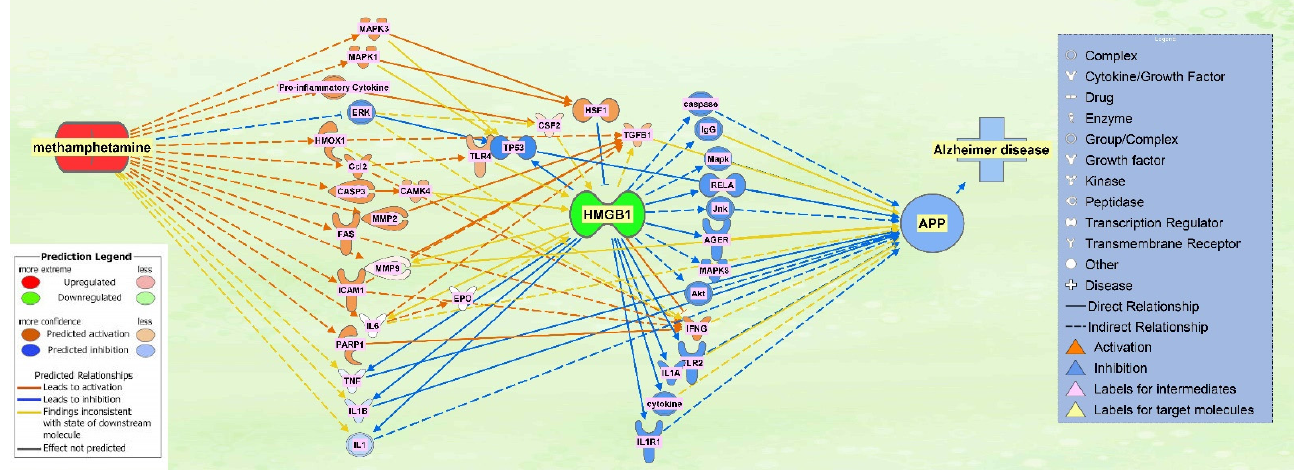
Figure 9. Activation of METH and Inactivation of HMGB1. METH was activated and HMGB1 was inactivated to illustrate the importance of the role of HMGB1 in METH influenced APP expression. The blocking of HMGB1 showed that even upon the exposure of METH, APP expression is inhibited.